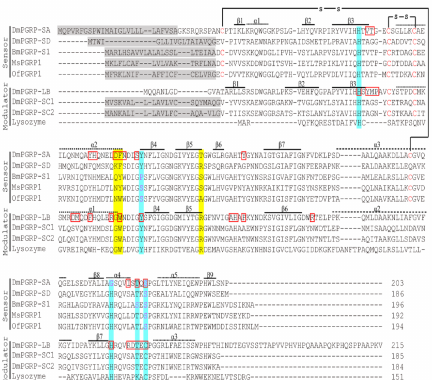
Figure 1. Sequence alignment of O. furnacalis PGRP1 with PGRPs from other insects. The GenBank accession numbers for the sequences used are as follows: DmPGRP-SA, Q9VYX7; PGRP-SD, Q9VS97; PGRP-SC1, Q9V3B7; PGRP-SC2, Q9V4X2; PGRP-LB, Q9VGN3; BmPGRP-S1, NM_001043371; MsP- GRP1, AF413068; Lysozyme, NP_041973. The predicted signal peptides are shaded in gray. The conserved Cys residues for disulfide bonds are indicated in red. Residues involved in the binding pocket in DmPGRP-SA and -LB are labeled in red boxes. Residues essential for T7 lysozyme activity are shaded in blue. The putative peptidoglycan-recognition positions are shaded in yellow. Secondary structures are assigned the above sequences from the N to C termini of amino acid